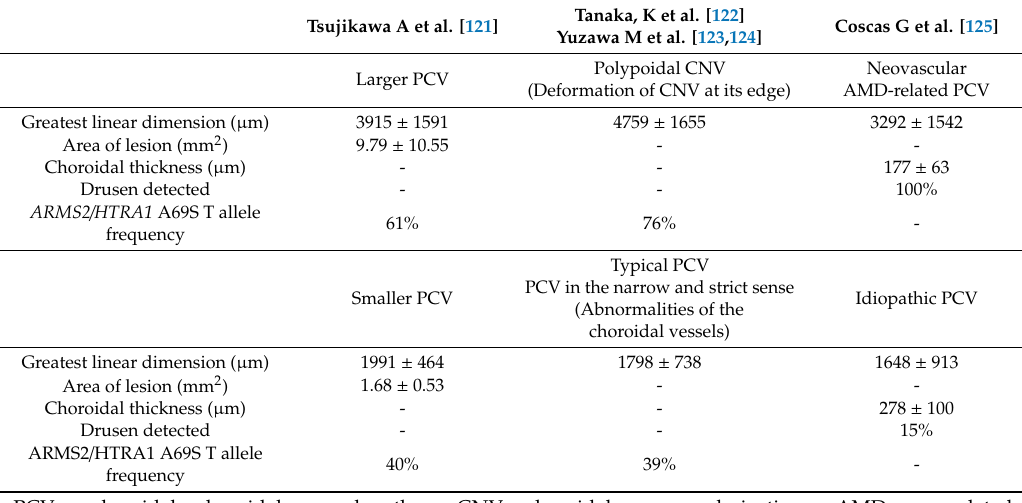
PCV, polypoidal choroidal vasculopathy; CNV, choroidal neovascularization; AMD, age-related macular